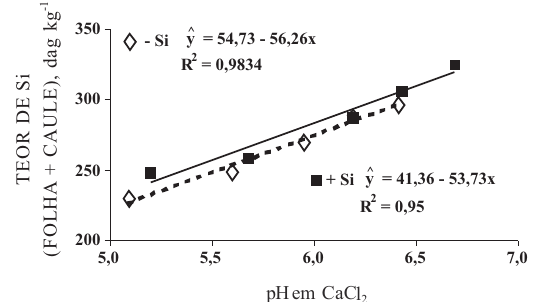
Figura 5. Teor de Si na parte aérea do arroz, em função do pH do solo rizosférico.